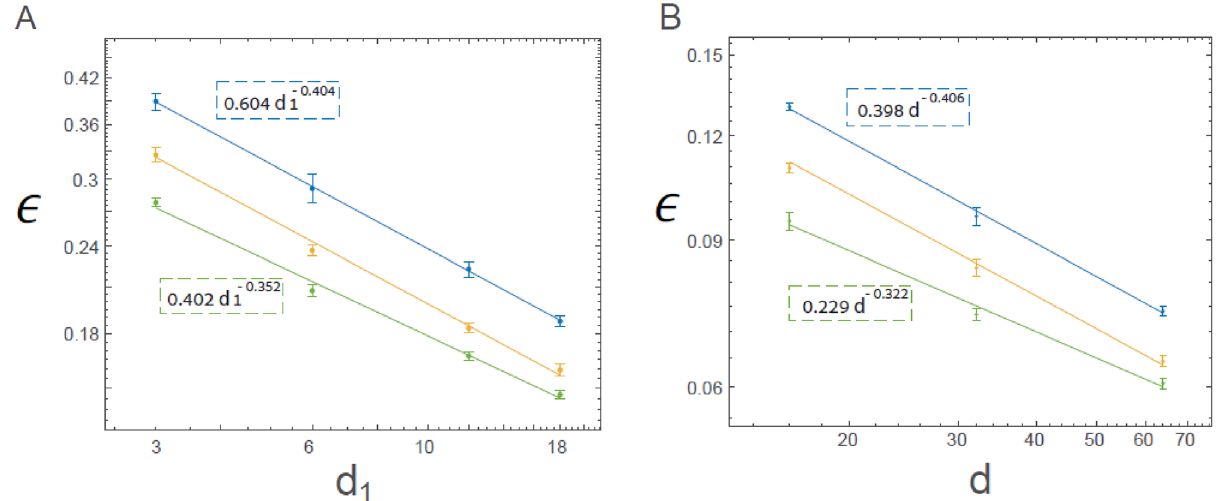
Figure 4. Conservation law indicating the optimal ratio between the depth of filters and their convolutional layer size. ( A ) Success rates and their standard deviation as a function of d 1 for the generalized LeNet d 2 d 2 = 16 = 4 architecture where d 1 d 1 3 (green) and 3 (blue) with fitted (color coded) power law (Supplementary d 2 = 16 Information), and the results for d 1 6 (yellow, as shown in Fig. 1B) are presented for reference. ( B ) Similar to ( A ), for the generalized VGG-16 architecture, where the number of filters in the n th convolution set ( n ≤ 4 ) n − 1 n − 1 is d · 2.5 (green) and d · 1.5 (blue) with fitted (color coded) power law (Supplementary Information),